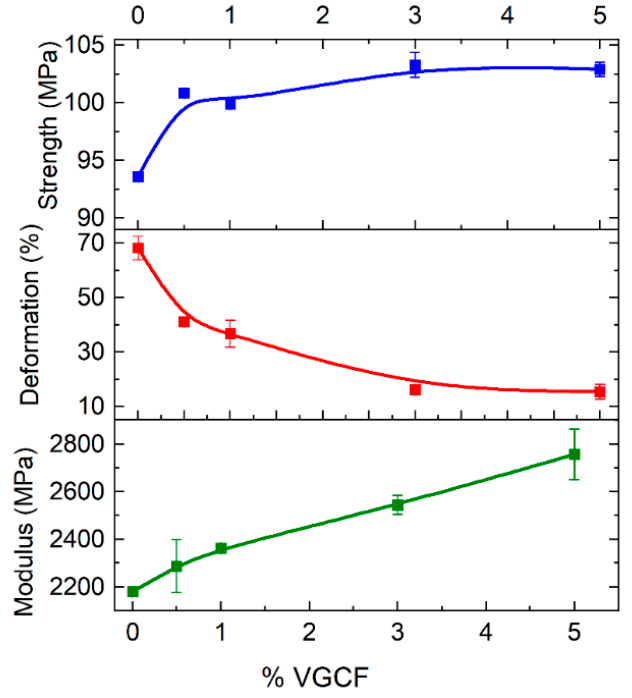
Figure 5. Dependence of strength, Young’s modulus, and deformation at break of the R-BAPB-based molded samples on the concentration of VGCF.